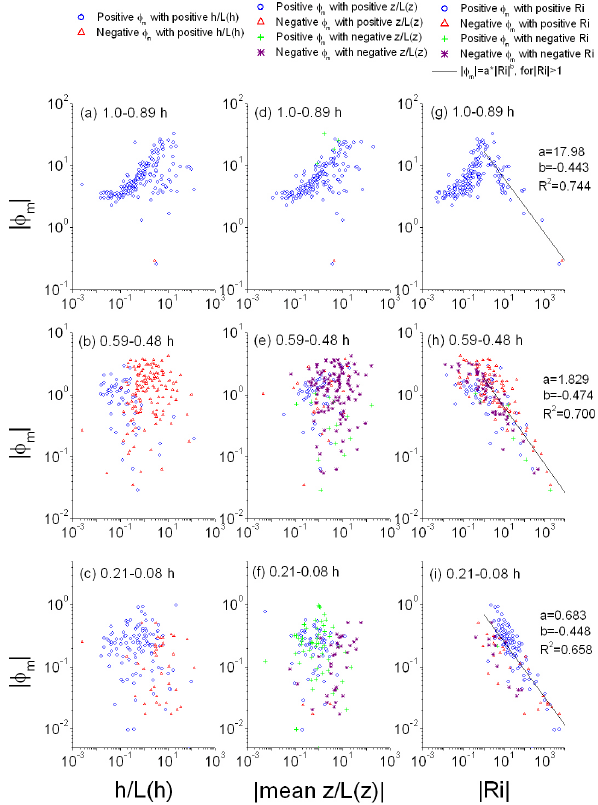
Fig. 4. Comparison of the relationship of the local similarity func- tion of wind φ m with different atmospheric stability parameters, i.e., h/L(h) at tree top, mean local z/L(z) , and local bulk Richardson num- ber Ri , in the top (1.0–0.89h), middle (0.59–0.48h) and low (0.21– 0.08h) layers. The lines in (g–i) are the simulated relationships between | φ m | and | Ri | for | Ri | > 1 on log-log scales.